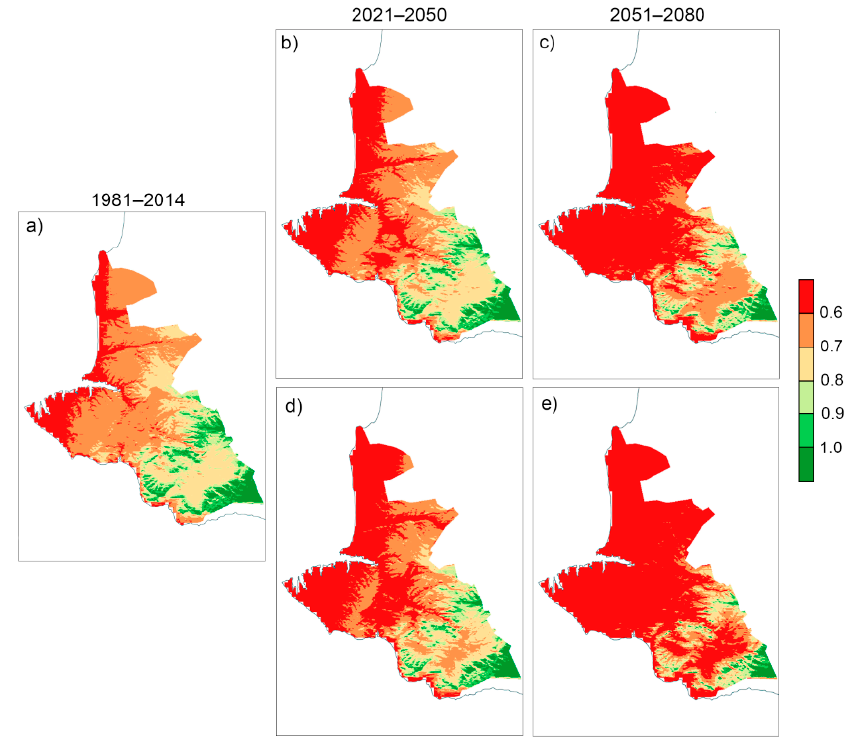
Figure 5. Spatial distribution of HTC over the territory of the Sevastopol region for the base period ( a ), and the expected changes under SSP2-4.5 ( b , c ) and SSP5-8.5 ( d , e ) for future periods.